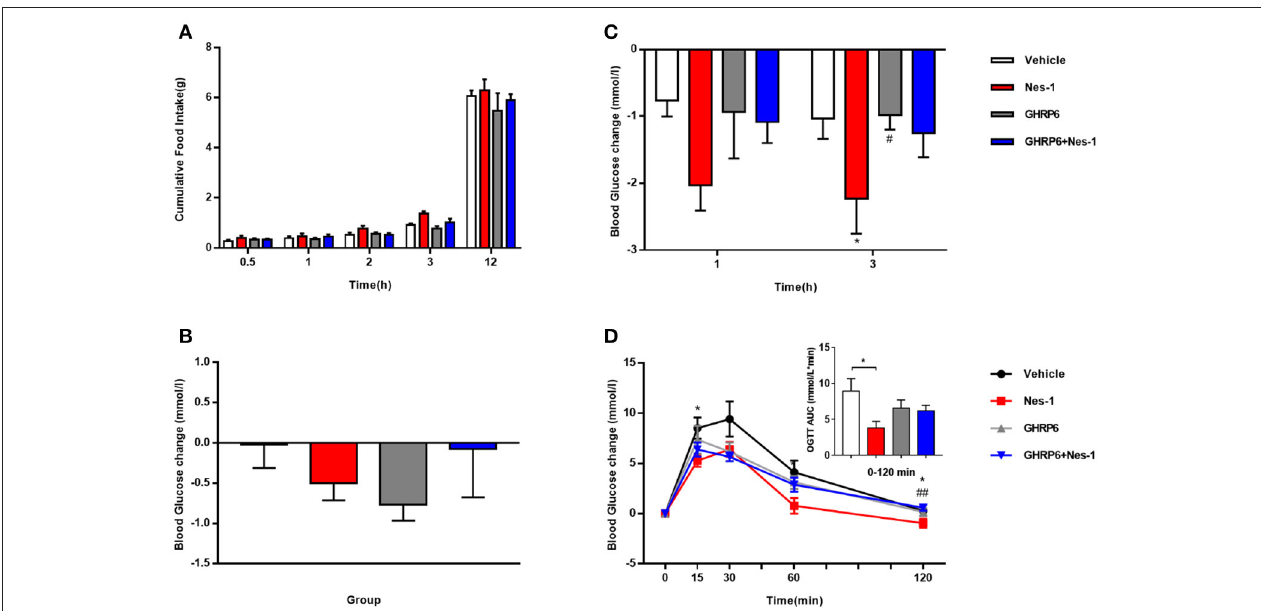
FIGURE 3 | [D-Lys3]-GHRP-6 attenuated nesfatin-1’s effects on glucose metabolism. GHSR + / + mice fed NCD underwent chronic tail vein administration of vehicle, nesfatin-1 (Nes-1), [D-Lys3]-GHRP-6 (GHRP-6), and [D-Lys3]-GHRP-6 + nesfatin-1 (GHRP-6 + Nes-1) for 11 days. (A) Food intake and (C) blood glucose changes after one acute injection in mice fasting for 6h. (B) Blood glucose changes after 11-day chronic injection compared with drug treatment prior. (D) OGTT after 8 days of injection in mice fasting for 16h. Data are expressed as mean ± SEM. Vehicle: n = 6; Nes-1: n = 6; GHRP-6: n = 6; GHRP-6 + Nes-1: n = 8. * P < 0.05 for the effect of nesfatin-1 vs. vehicle; # P < 0.05, ## P < 0.01 for the effect of GHRP-6 + nesfatin-1 vs. nesfatin-1. One-way ANOVA was applied to analyze the statistical difference.